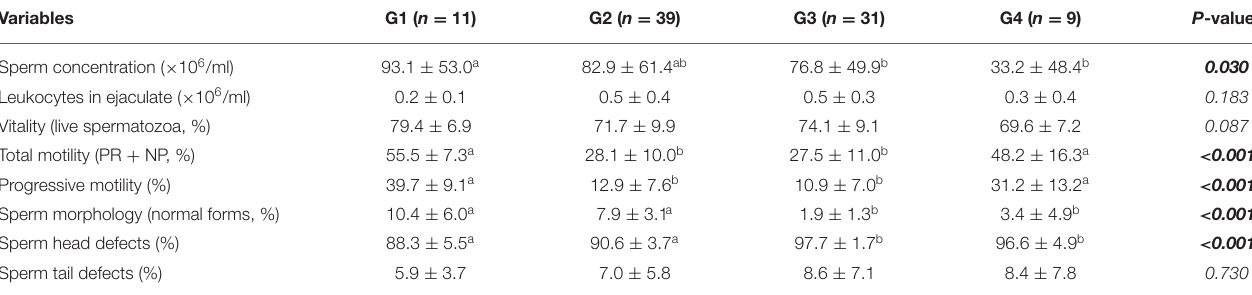
TABLE 2 | Semen quality parameters (mean ±